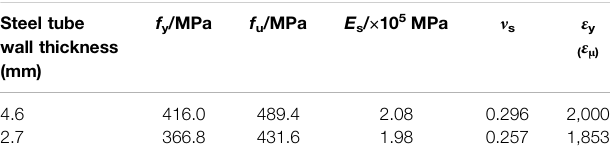
TABLE 3 | Measured mechanical properties of steel